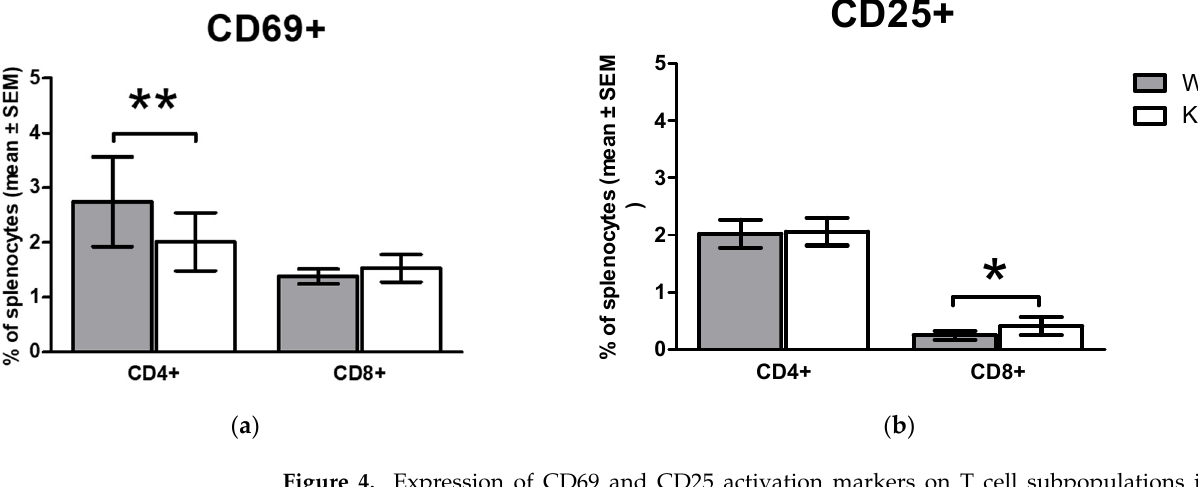
Figure 4. Expression of CD69 and CD25 activation markers on T cell subpopulations in vivo . ( a ) shows the ratio of splenic CD69+ ( b ) the ratio of CD25+ CD4+ and CD8+ T cells in wild type (WT) and functional KO mice. Data are presented as mean ± SEM, ( a ) n = 9, ( b ) n = 3, * p < 0.05, ** p < 0.01.